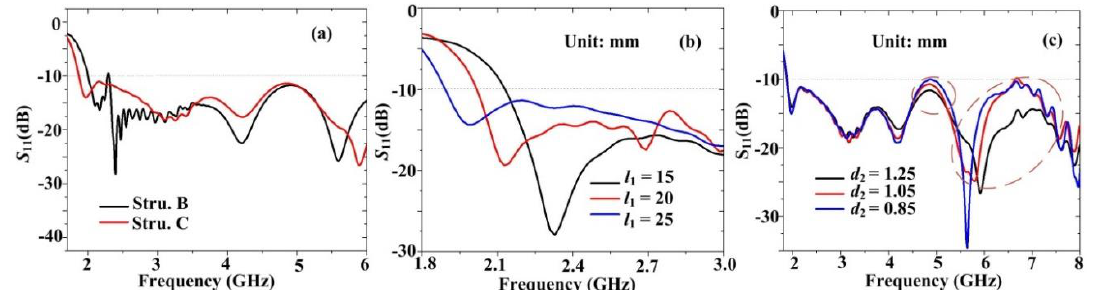
Figure 4. ( a ) Simulated reflection coefficients of Structure B and Structure C, ( b ) S 11 for different maximum groove depths l 1 of Structure C, and ( c ) S 11 for different groove gaps d 2 of Structure C .